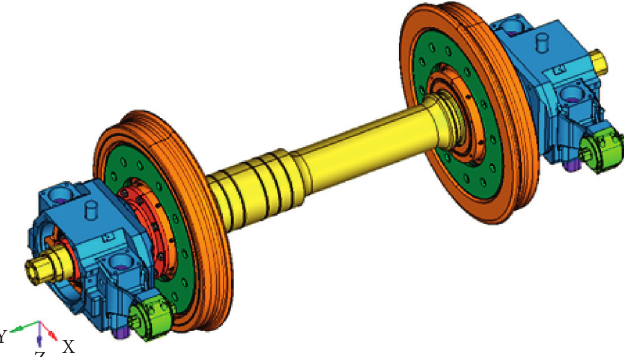
Figure 1: Basic elements of the automatic gauge-changing wheelset